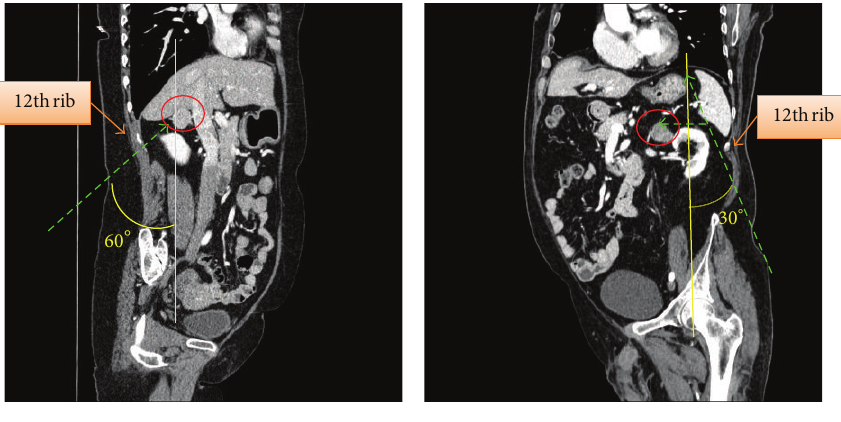
Figure 2: Comparison of right and left-sided